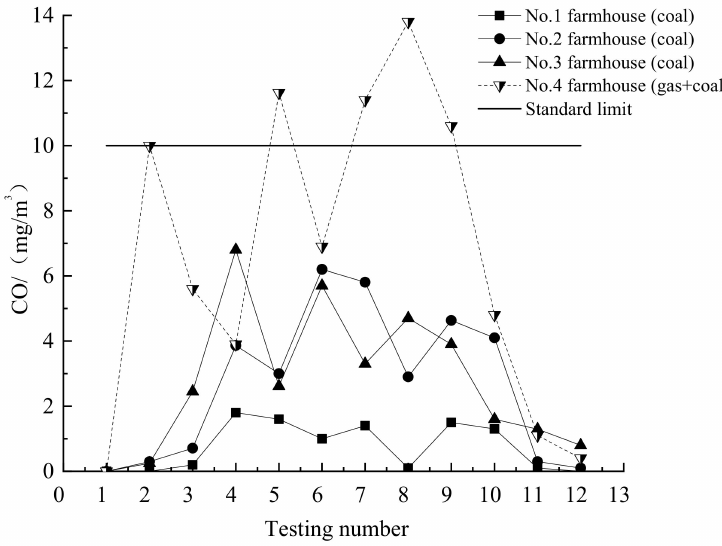
Figure 5. Changes in CO content in coal-fired